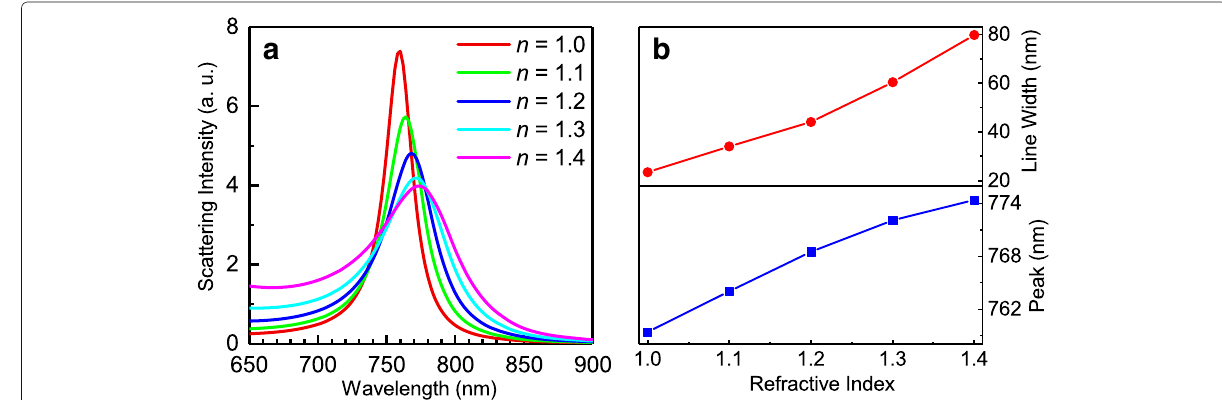
Fig. 4 a Evolution of the scattering spectrum of the Si NS placed on the 50-nm-thick Au substrate with increasing refractive index of the surrounding medium. b Dependence of the line width (upper part) and the peak wavelength (lower part) of the MD resonance on the refractive index of the surrounding